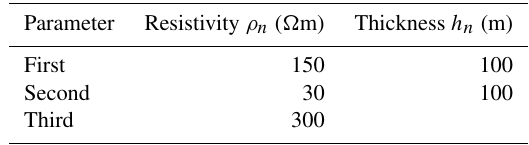
Figure 1. GREATEM model based on a three-layer earth model. The TX is the transmitter line on the ground and the line length is 1000m; the transmitter current is 10A and the frequency is 25Hz. The RX is the receiving coil and the equivalent area is 1000m 2 ; the offset is 50m, the flight altitude is 35m, and the sample rate of re- ceiver is 32kHz. The other model parameters are shown in Table 1. Table 1. Parameters of the three-layer earth